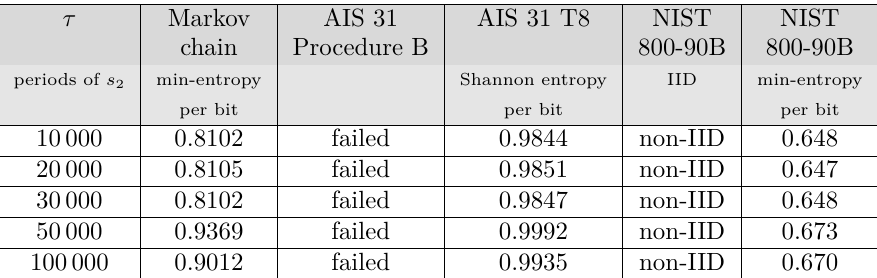
Table 5: Entropy estimation using high order Markov chains, AIS 31 and NIST 800-90B tests, when two internal ROs and the sampling method was used. Dependencies are modeled using 8 th order Markov